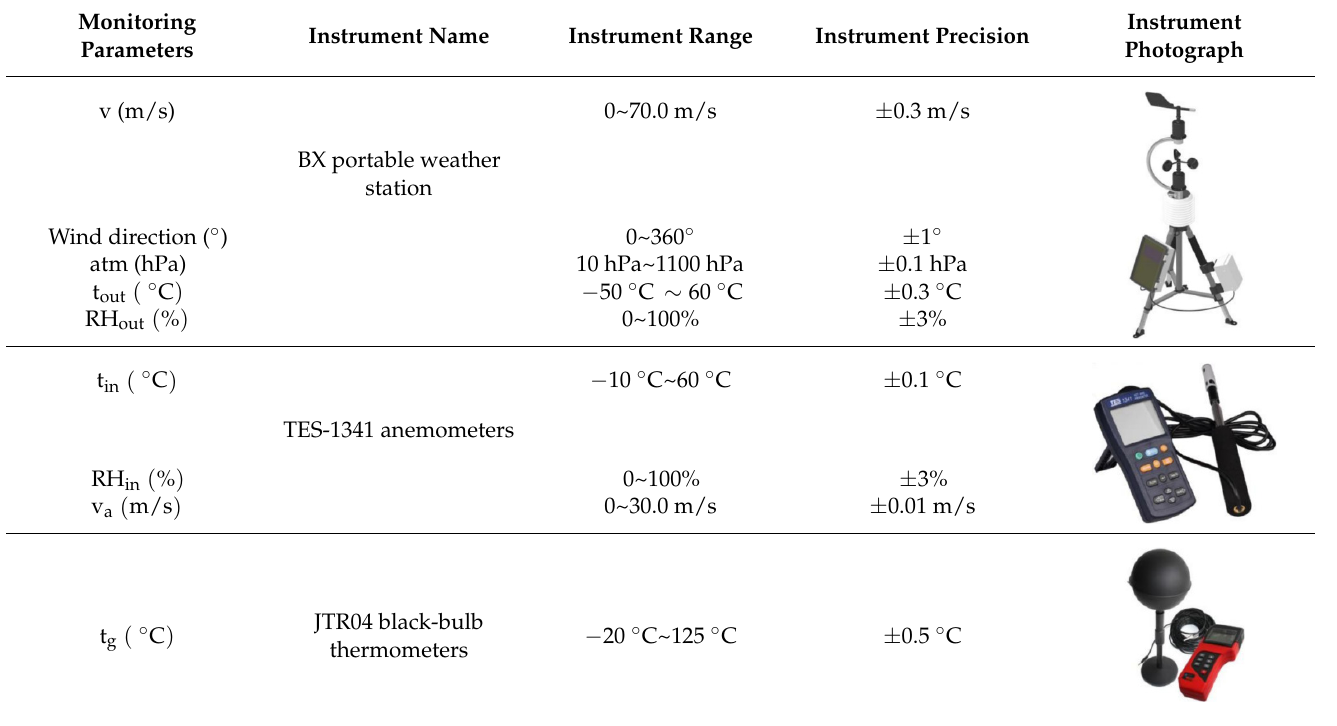
Table 2. Measurement equipment introduction.